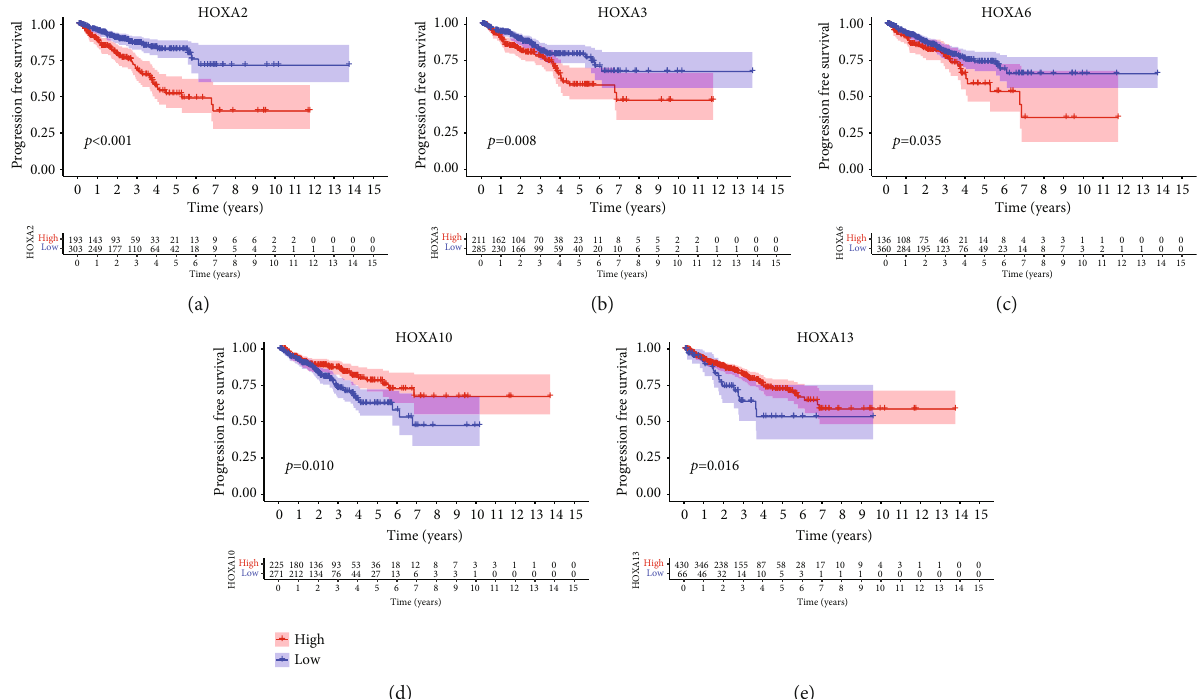
Figure 7: K-M curves for the progression-free survival of su ff erers in the high and low groups based on the mean expression of (a) HOXA2, (b) HOXA3, (c) HOXA6, (d) HOXA10, and (e) HOXA13 in TCGA